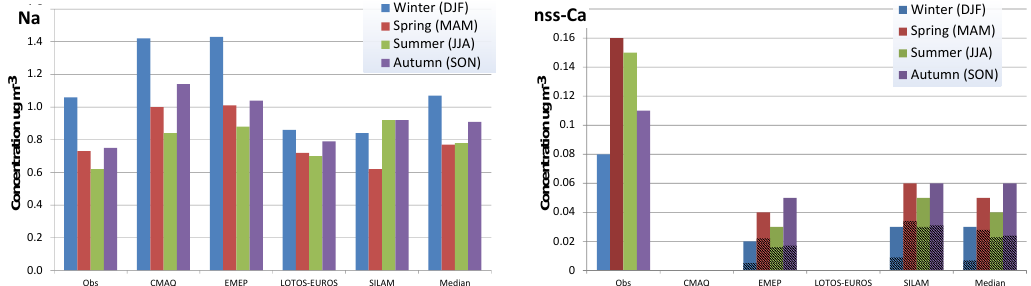
Figure 5. Observed and predicted seasonal concentrations of sodium and non-sea-salt calcium in aerosol, mean over the EMEP stations (µgm − 3 ). Modelled Na + concentrations are based on sea salt containing 30.8% Na + . Model values of non-sea-salt calcium assume 10% Ca 2 + content of desert dust (shaded bottom part of the columns) and 3.5% calcium content of non-carbonaceous primary anthropogenic PM (the non-shaded upper